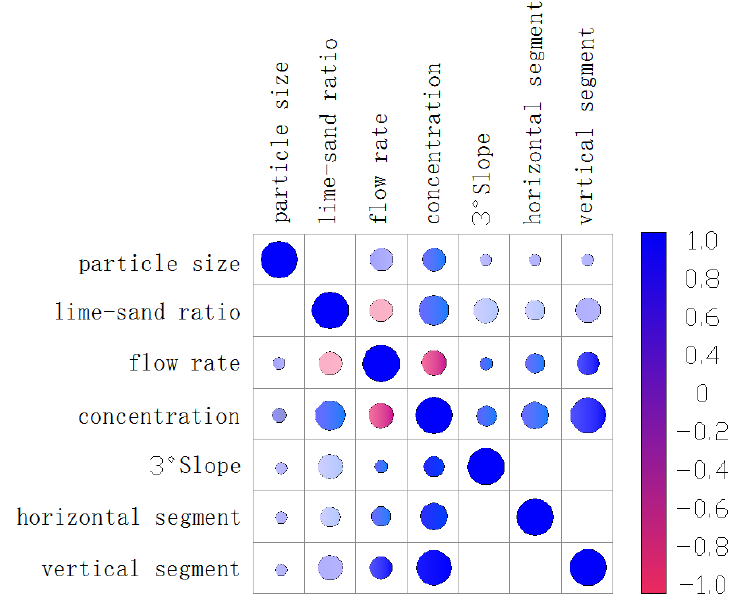
Figure 5. Correlation graph.